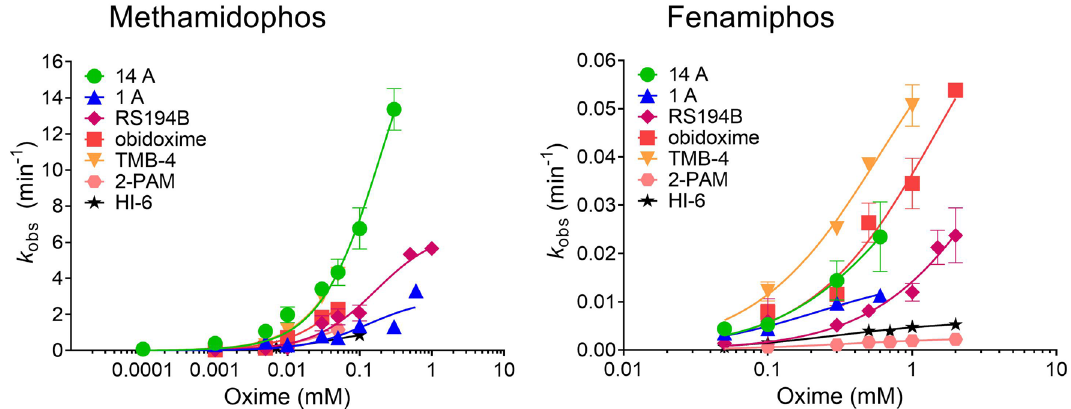
Figure 6. Reactivation kinetics of pesticide-inhibited hAChE by selected oximes. Reactivation constants were determined by nonlinear regression of experimental data and are presented in Table 1. Values are expressed as mean ± SEM from at least three experiments.